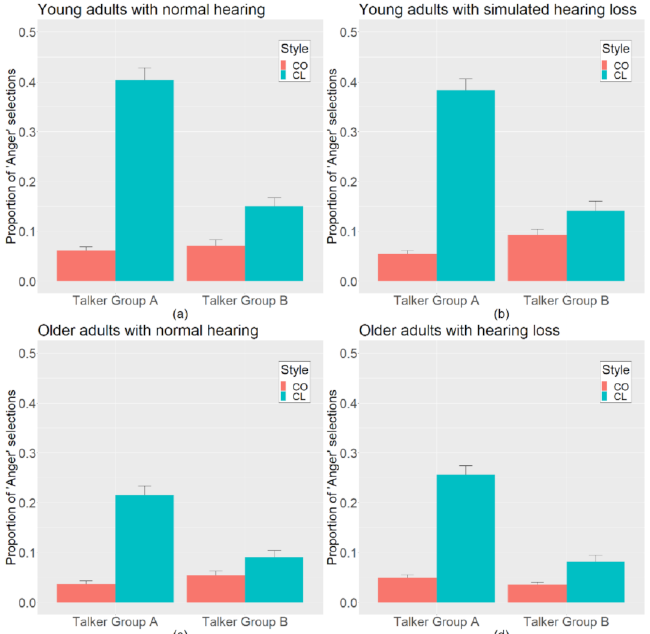
Figure 2. Proportion of “Anger” selections for clear (CL) and conversational (CO) speech by ( a ) young adults with normal hearing; YNH, ( b ) young adults with a simulated hearing loss; YSIM, ( c ) older adults with normal hearing; ONH, and ( d ) older adults with hearing loss; OHL. Error bars represent one standard